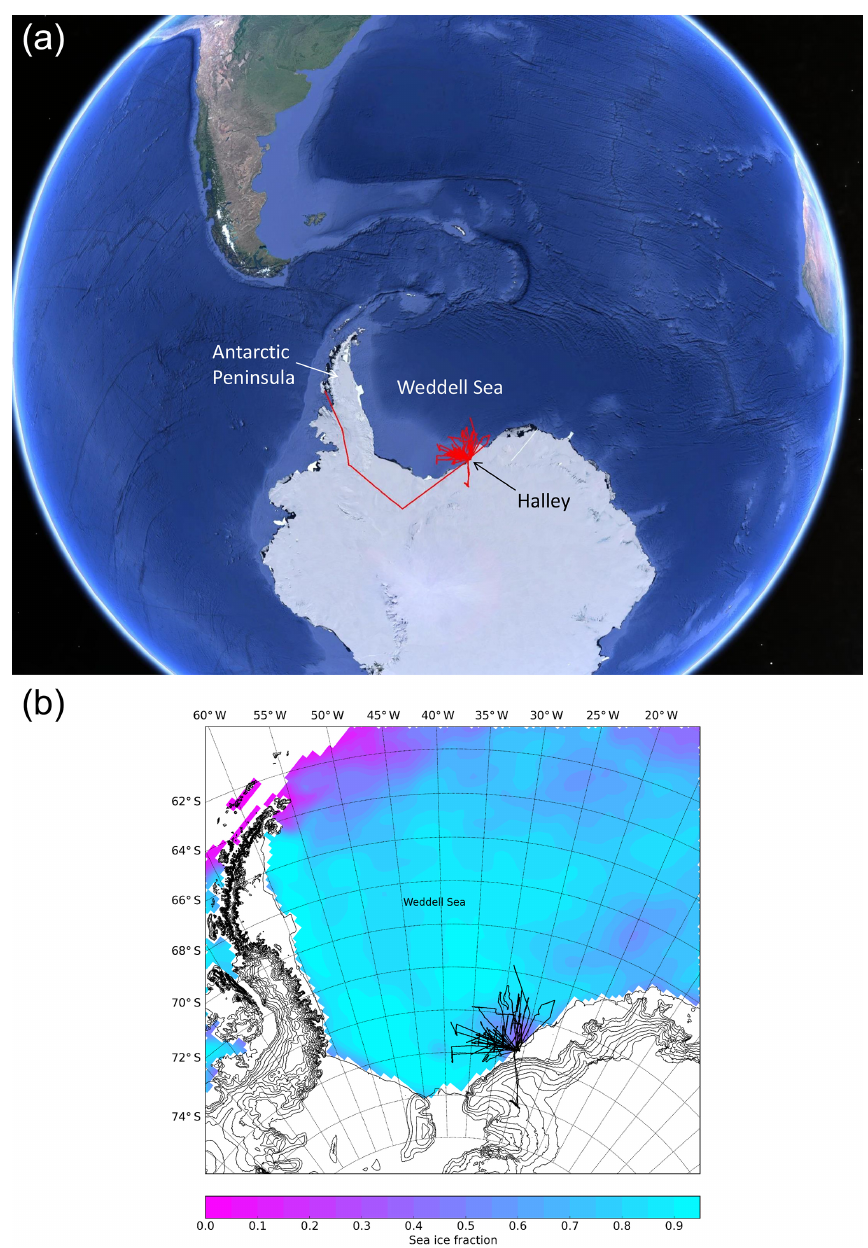
Figure 1. (a) Flight tracks during the MAC field project (source: Google Earth). Panel (b) shows the sea ice fraction on the Weddell Sea (Maslanik and Stroeve, 1999) during the experimental